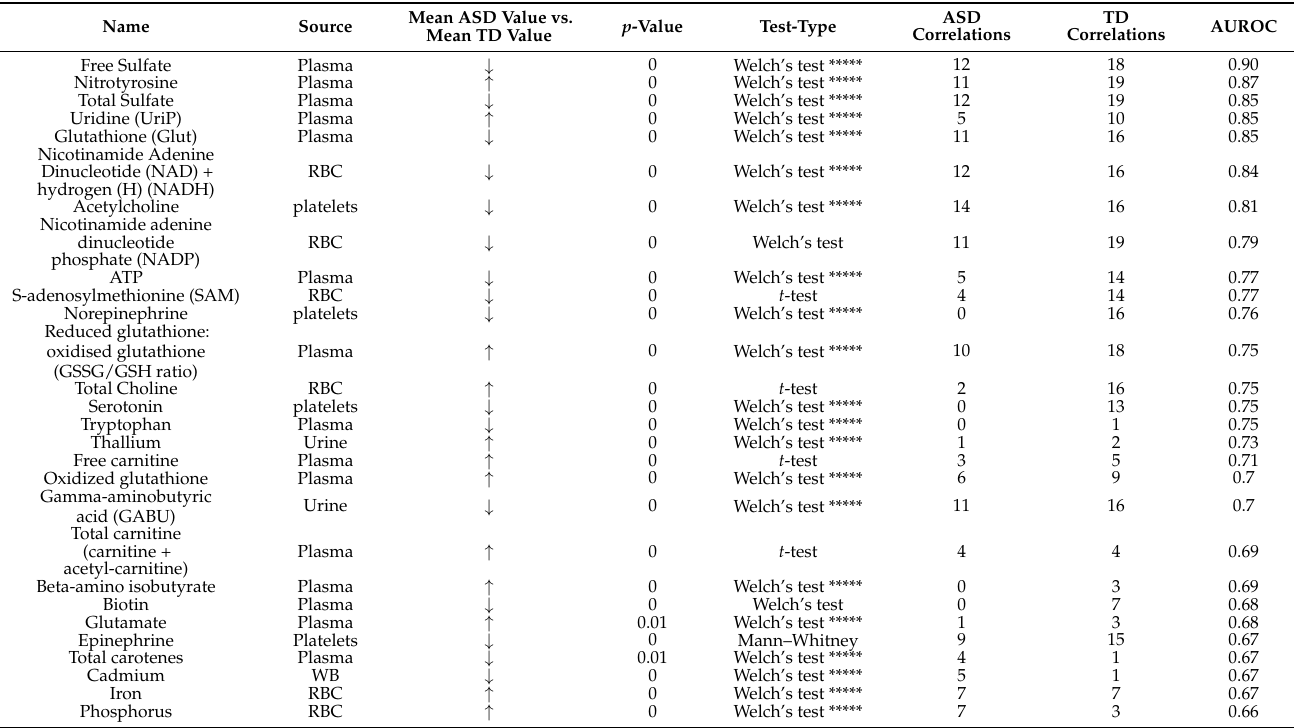
Figure 2. Sankey diagram showing the biochemical and xenobiotic measurements that served as the inputs to the hypothesis testing protocol. Measurements that had a p -value greater than 0.05 or a false discovery rate greater than 0.10 were deemed to not be significantly different (n.s.) between the ASD and TD groups. The measurements that were determined to be significant were used in the development of the FDA and SVM models. Table 1. Univariate and correlation analysis results ordered by AUROC. Univariate analysis was performed by both determining the optimal statistical test to perform to compare the ASD and TD groups as well as calculating the AUROC between them. FDR was determined using the leave-one- out approach to determine the robustness of each of the